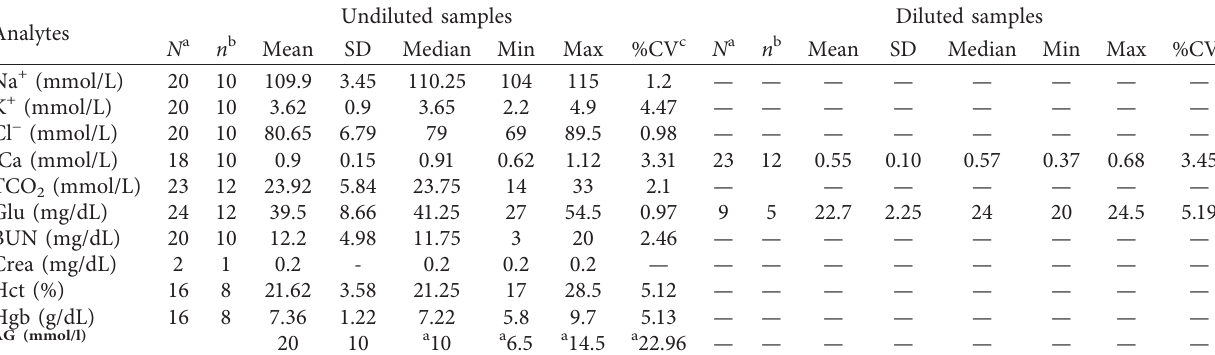
Table 2: Biochemistry results from heparinized undiluted and heparinized dilute blood samples from 12 marine toads ( Rhinella marinus ) using an i-STAT portable analyzer. Undiluted samples Diluted Analytes